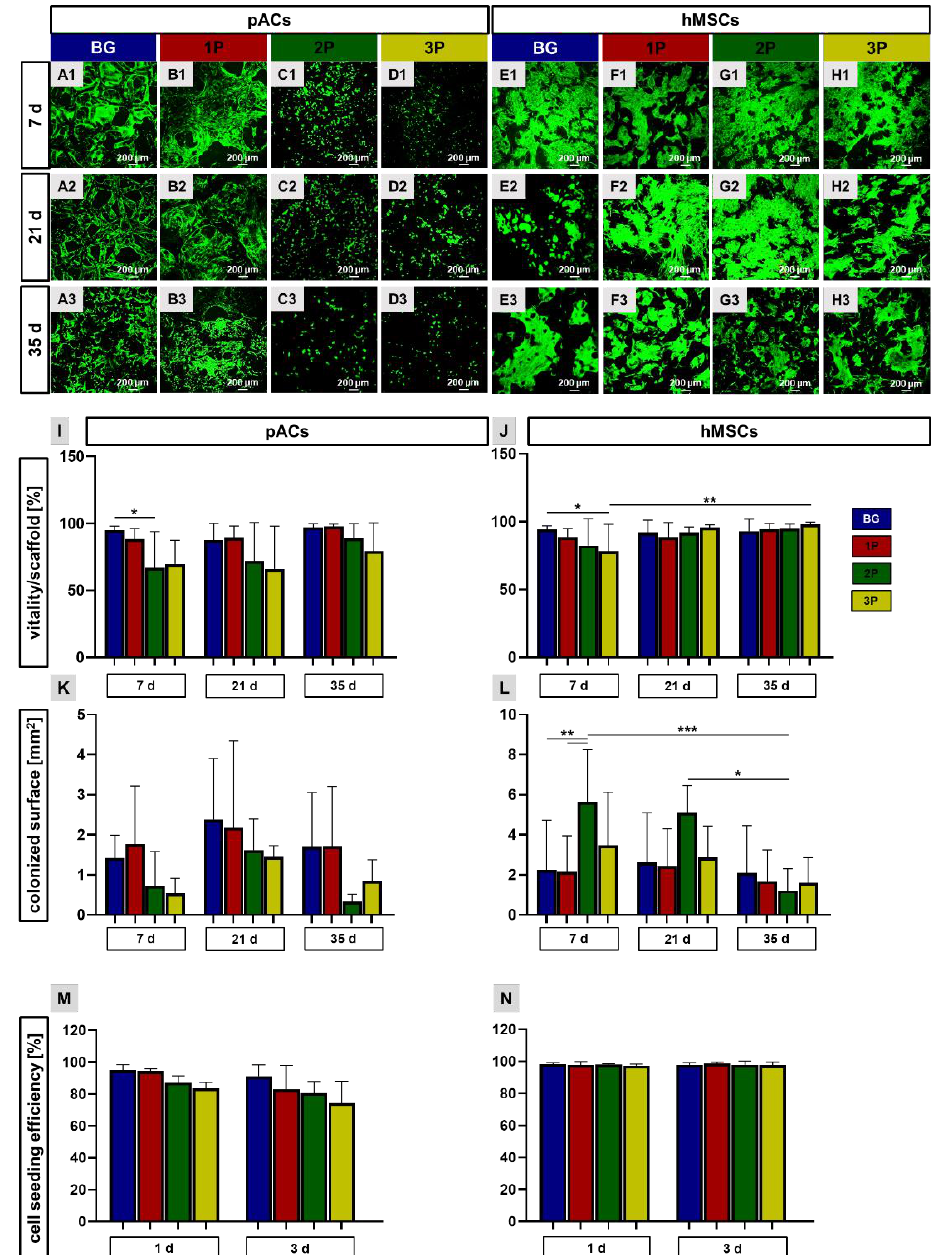
Figure 6. Viability assay of colonized scaffolds, calculation of the cell viability per scaffold surface, the colonized scaffold surface and the cell seeding efficiency. Representative pictures of three independent experiments show vital (green) and dead (red) porcine articular chondrocytes (pACs) ( A1 – D3 ) and human mesenchymal stem cells (hMSCs) ( E1 – H3 ) over a cultivation time of 7 to 35 days (d). pACs ( I ) and hMSCs ( J ) viability per scaffold surface was calculated after 7, 21 and 35 d. Results of the pACs ( K ) and hMSCs ( L ) colonized surface over the cultivation time. The cell seeding effi- ciency (%) was calculated for pACs ( M ) and hMSCs ( N ) after 1 and 3 d, with no significant differ- ences. The pure bioactive glass (BG, blue), single (1P, red), twofold (2P, green) and threefold PLGA infiltrations (3P, yellow). Three independent experiments ( n = 3) with cells from three different do- nors were performed. Two-way ANOVA combined with the post hoc Tukey´s multiple comparison test between the groups: p values: * p < 0.05, ** p < 0.01 and *** p < 0.005. Scale bar: 200 µm.